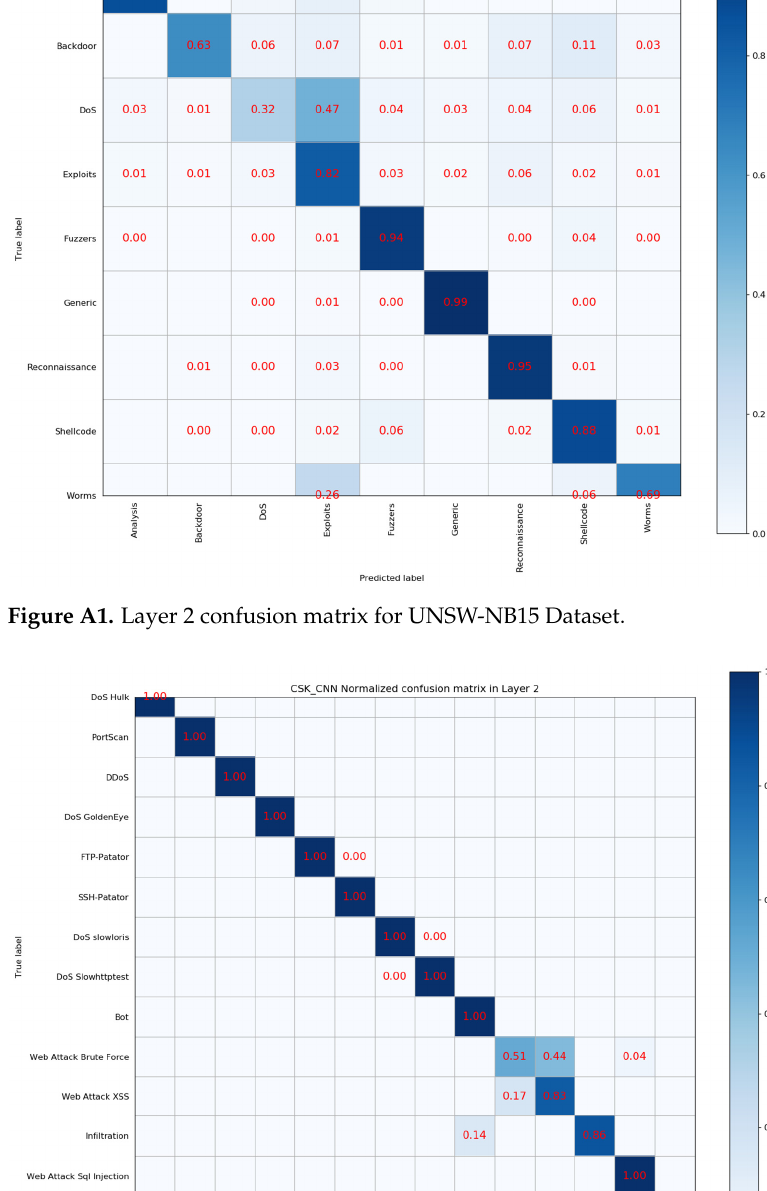
Table A2. Layer 1 confusion matrix for CICIDS2017 Dataset.